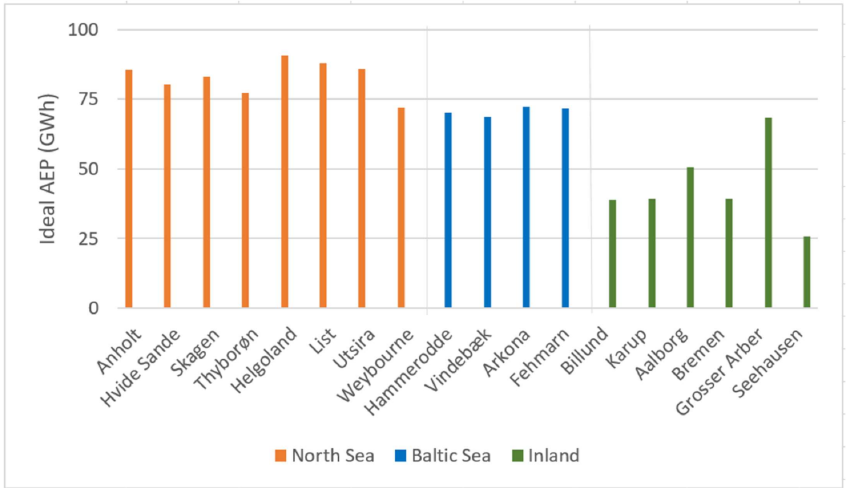
Figure 6. The ideal Annual Energy Production (AEP) for each station in the North Sea, Baltic Sea, and inland.